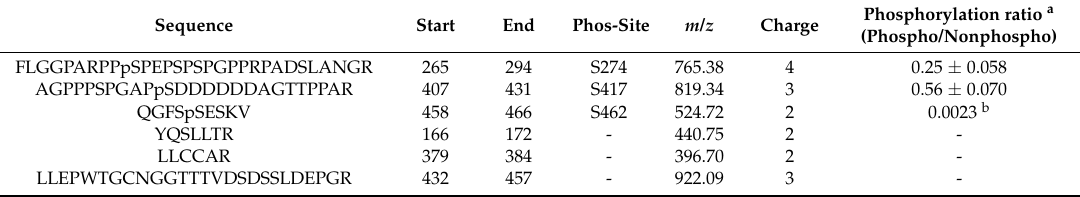
Table 1. Tryptic peptide fragments and phosphorylation ratios in FLAG-Adrb1 KI mouse heart. Sequence Start End Phos-Site m / z Charge